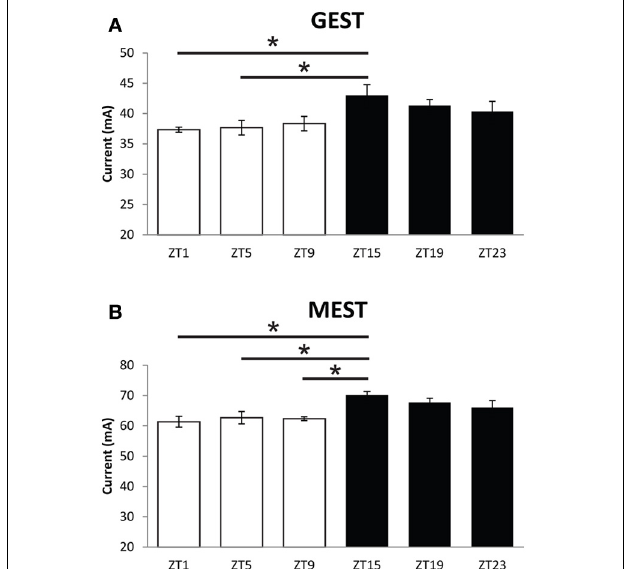
FIGURE 1 | Diurnal effects on seizure threshold. Time-of-day variation in (A) generalized (GEST) and (B) maximal (MEST) electroshock seizure threshold. Male C57BL/6J mice (8–9 weeks of age) were housed individually and tested for electroshock seizure thresholds at different times during the 14:10 Lights-on:Lights-off diurnal cycle. One-Way ANOVA for GEST, p = 0 . 023, MEST, p = 0 . 004; ( N = 6). Student-Newman-Keuls post-hoc test for all pairwise comparisons are shown for differences between groups for GEST and MEST ( ∗ p < 0 . 05). ZT, zeitgeber time. Light bars = Lights on, Dark bars = Lights off.